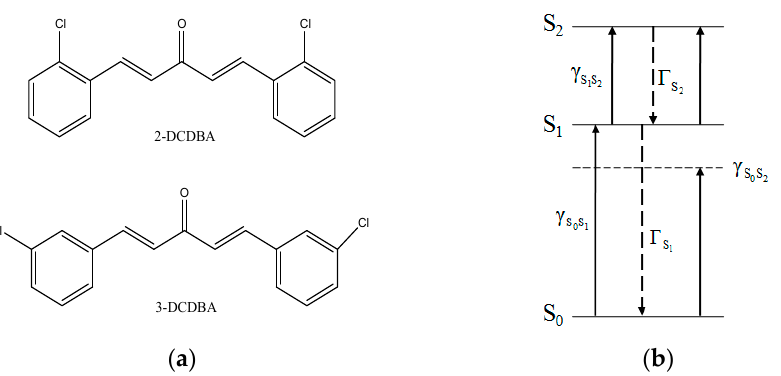
Figure 1. ( a ) Molecular structure diagrams of 2-DCDBA and 3-DCDBA; ( b ) scheme of the three-level theory model. Table 1. Excitation energies and transition dipole moments of 2-DCDBA and 3-DCDBA.